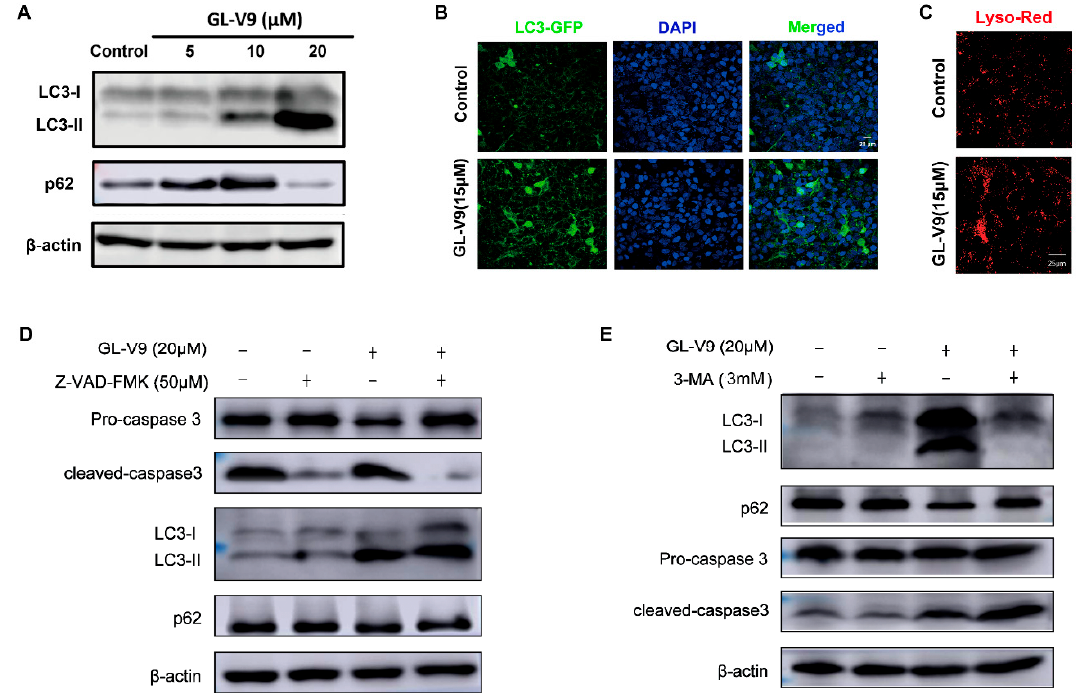
Figure 2. High concentration of GL-V9 induces autophagy of A431 cells, which potentially antagonizes the effect of apoptosis induction. ( A ) Western blot assays were used to examine the expression of autophagy proteins p62 and LC3. ( B ) Immunofluorescence detection of the distribution of GFP-LC3 in A431 cells. Scale bar = 20 μ m . ( C ) The lysosome of A431 cells was observed by LysoTracker Red. Scale bar = 25 μ m . ( D ) A431 cells were co-treated with GL-V9 with caspase inhibitor Z-VAD-FMK, protein level of caspase 3 and LC3 were assayed. ( E ) A431 cells were co-treated with GL-V9 with autophagy inhibitor 3-MA for 12 h. Then 3-MA was withdrawn and cells were further treated with GL-V9 for another 24 h. Protein level of caspase 3, p62, and LC3 were assayed.